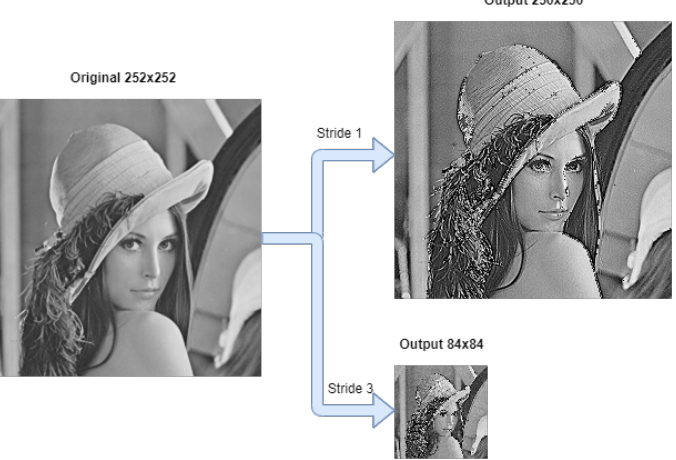
Figure 8. Right upper output image represents a sharpen filter application with stride 1, padding 0. Right bottom image represents a sharpen filter application with stride 3, padding